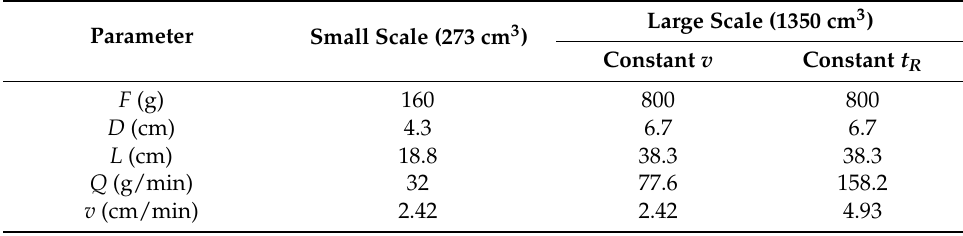
Table 4. BIC model prediction of Mortiño SFE kinetics at 30 MPa and 313 K in a large-scale extraction cell (1350 cm 3